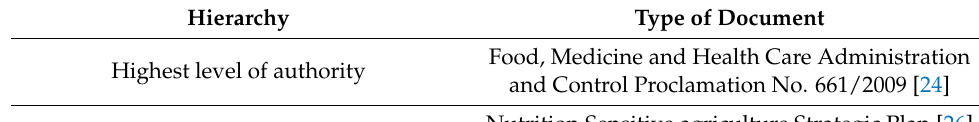
Table 3. Hierarchy of the authoritativeness of policy documents, 2021 ( n =